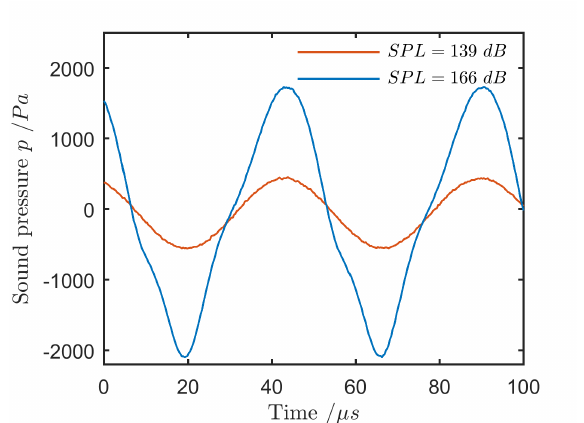
Figure 10. Sound pressure (microphone measurement) on a single point with sound pressure levels of L p = 139 dB and L p = 166 dB.